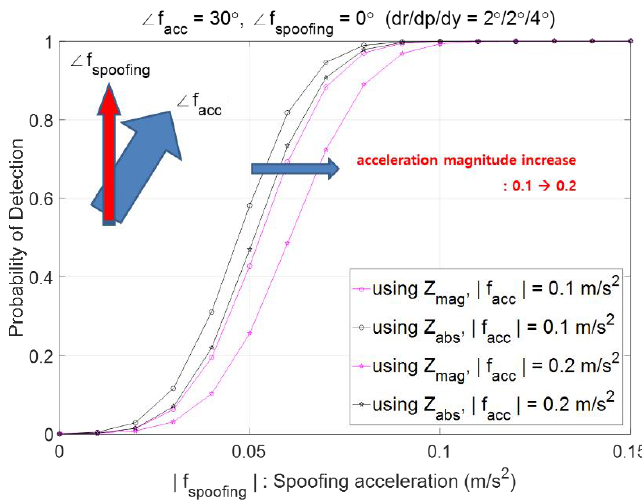
Figure 5. Probability of spoofing detection , 𝑃 𝑑,𝑚𝑎𝑔 and 𝑃 𝑑,𝑎𝑏𝑠𝑁 when 𝒇 𝒂𝒄𝒄 heads northeast.